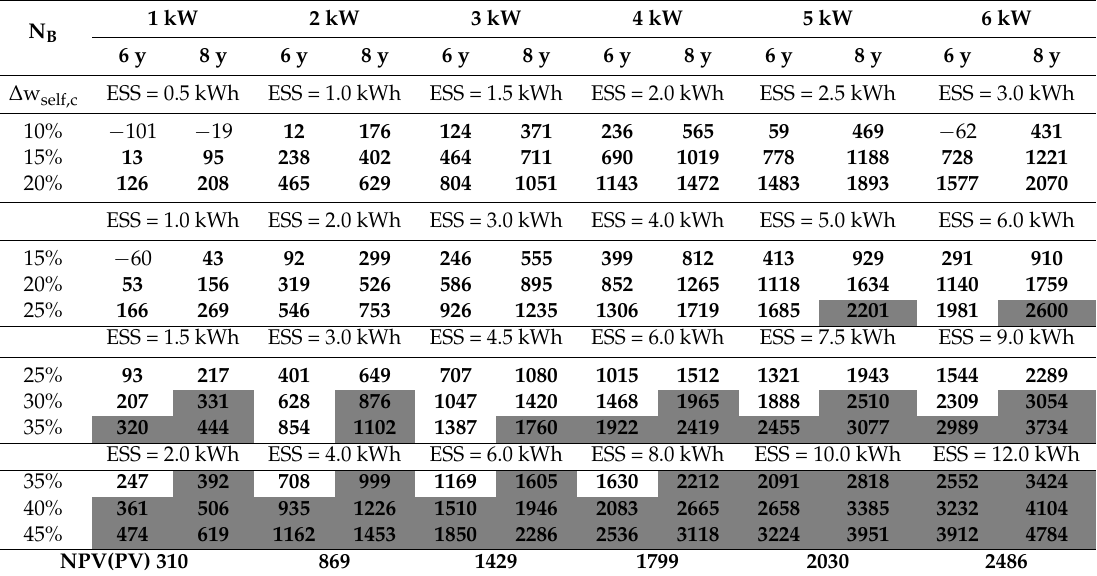
Table 4. Net Present Value ( € ) of integrated PV-battery systems.